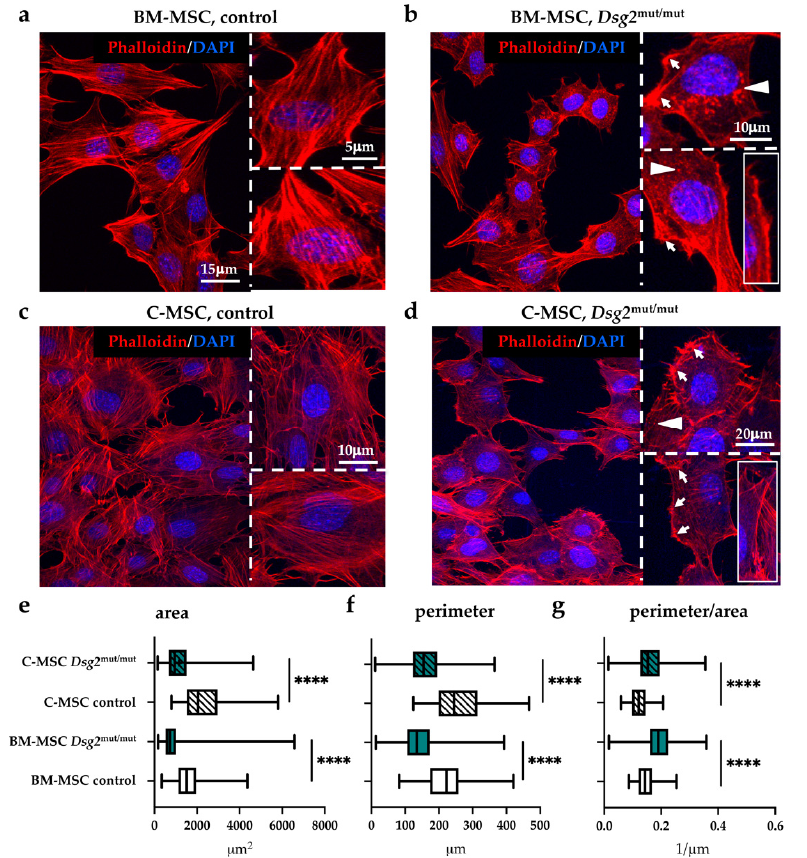
Figure 2. AC-linked Dsg2 variant affects cytoskeletal organization and morphology of cardiac and bone marrow mesenchymal stromal cells. ( a – d ) Confocal IF analysis of cultured cardiac- and BM-MSCs isolated from control or Dsg2 mut/mut mice. Cells were stained with AlexaFLUOR ® -568 conjugated phalloidin (red signal). Nuclei were counterstained with DAPI (blue signal). White arrows indicate focal adhesions, and arrowheads evidence actin puncta. Insets show sub-membrane thick actin filaments. ( e – g ) Morphometric evaluation of cell surface, perimeter, and perimeter/area ratio in cultured cardiac and BM-MSCs isolated from control or Dsg2 mut/mut mice. A total of 110 cells for each study group were analyzed. Whiskers represent min to max values. **** p ≤ 0.0001.